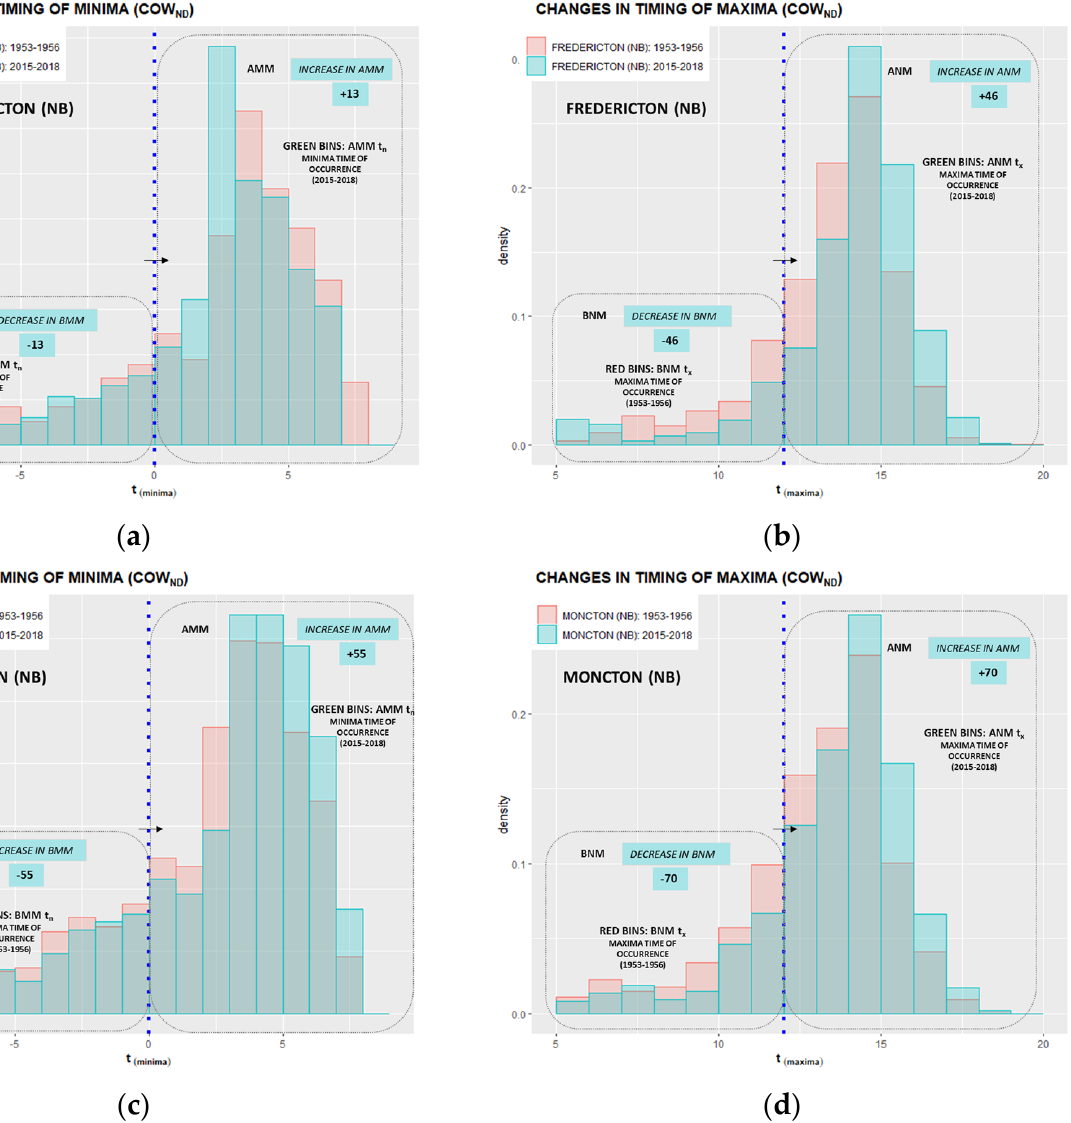
Figure A20. Atlantic Canada climate region: Fredericton (NB) and Moncton (NB). Time evolution of the Diurnal Extrema Timing (DET) histograms at Fredericton ( a , b ), and Moncton ( c , d ) stations. Migration of the Before Midnight Minima (BMM) to After Midnight Minima (AMM) and migration of the Before Noon Maxima (BNM) to After Noon Maxima (ANM) between four-year averages at the beginning (1953–1956) and ending (2015–2018) of data ranges. The blue dotted line represents midnight delineation ( left ) and noon delineation ( right ).